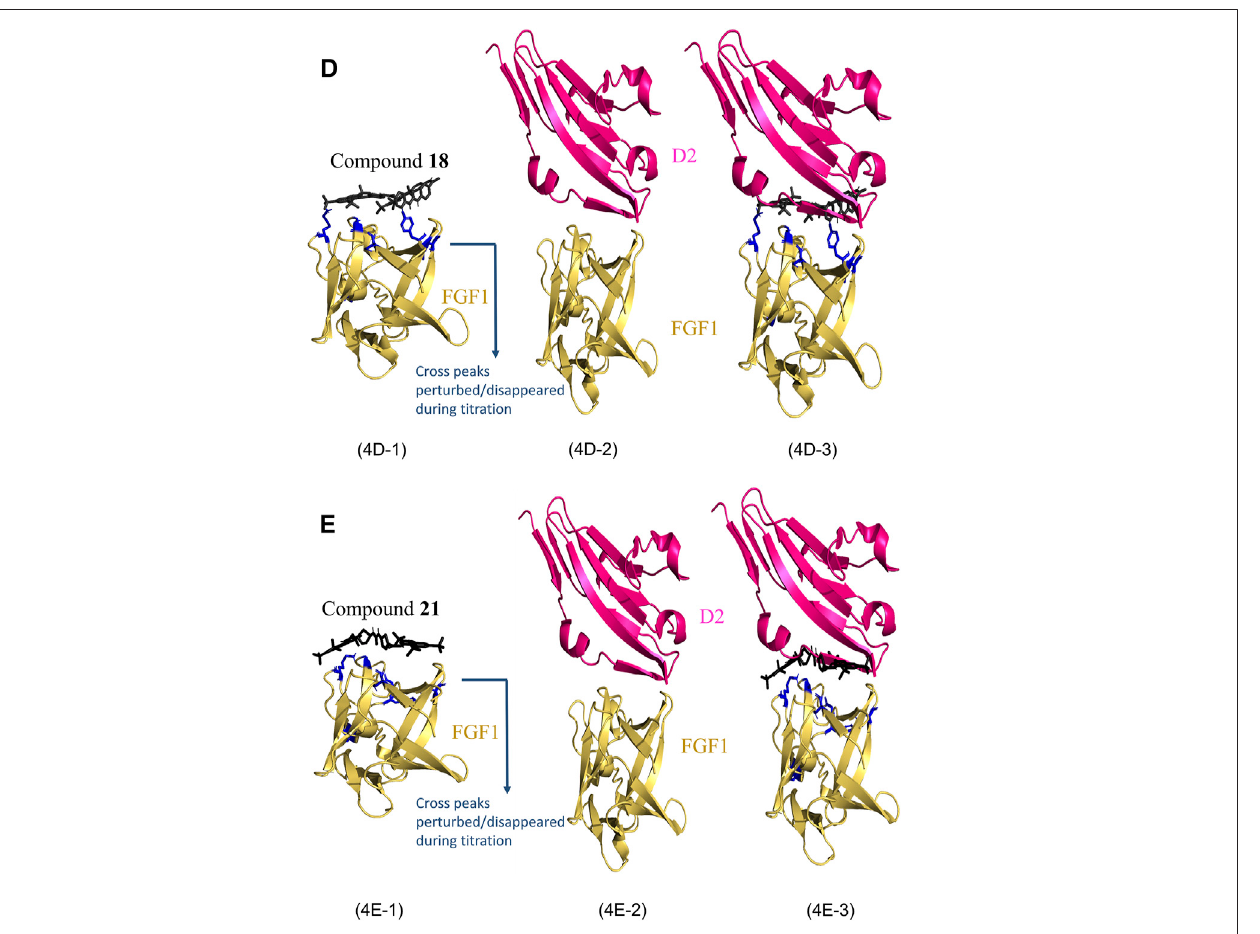
proliferation, which indicated an inhibition of the interaction of FGF1 with its receptor